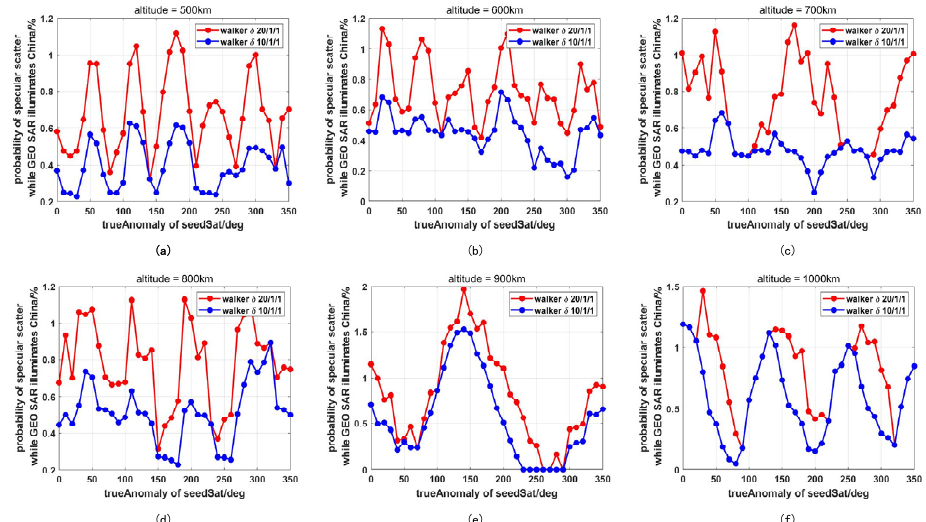
Figure A1. Probability of specular scatter while the GEO SAR is illuminating China changing with the true anomaly of the seed satellite. The red line represents the probability considering a LEO SAR constellation which uses a 20/1/1 walker pattern and the blue line represents the probability considering a LEO SAR constellation which uses a 10/1/1 walker pattern. ( a – f ) represent the altitude of 500 km, 600 km, 700 km, 800 km, 900 km, and 1000 km, respectively.